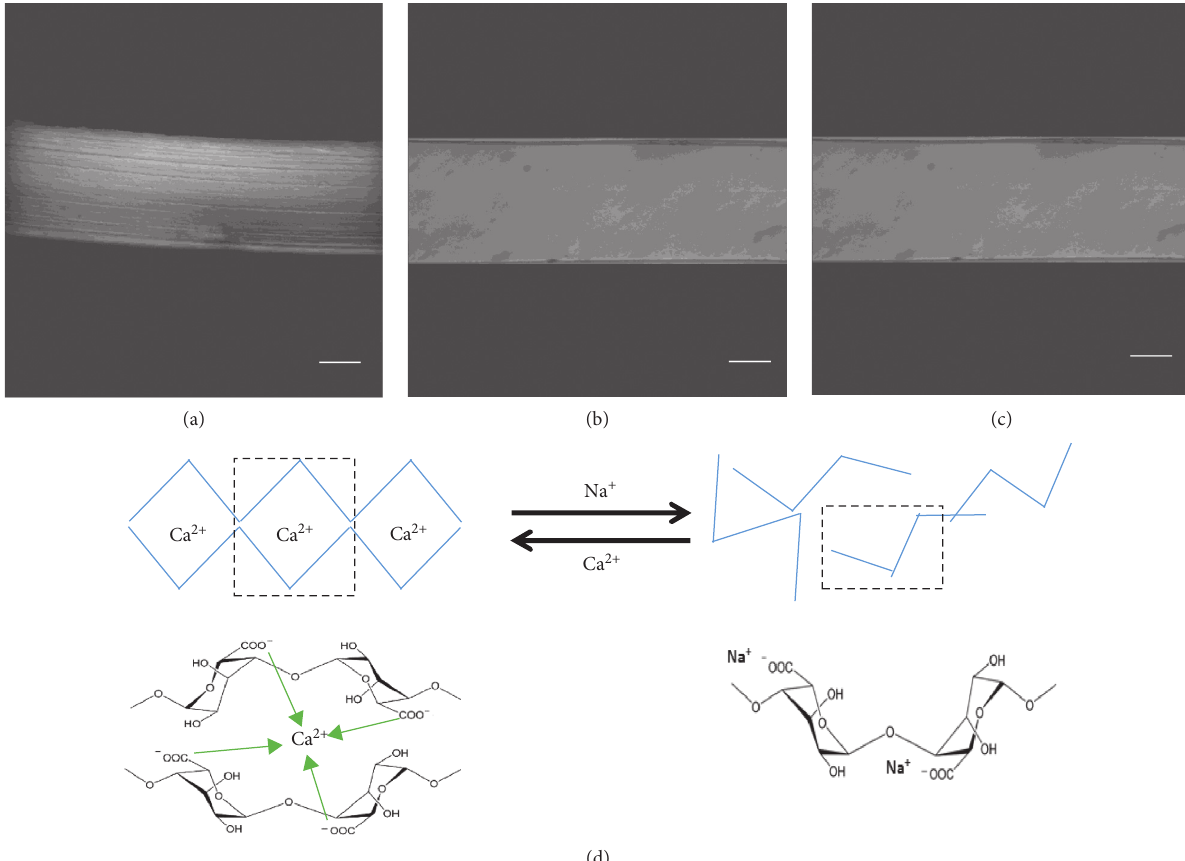
Figure 2: The forming process of microchannels recorded by the layer confocal microscopy. (a) The micromolded Ca-Alg is encapsulated within the bulk gel. (b) The Ca-Alg is liquefied. (c) The liquefied Ca-Alg is flushed out, and the microchannels are formed. (d) Schematic diagram of liquefying the Ca-Alg by the effect of ion-exchange. Bar: 200 μ